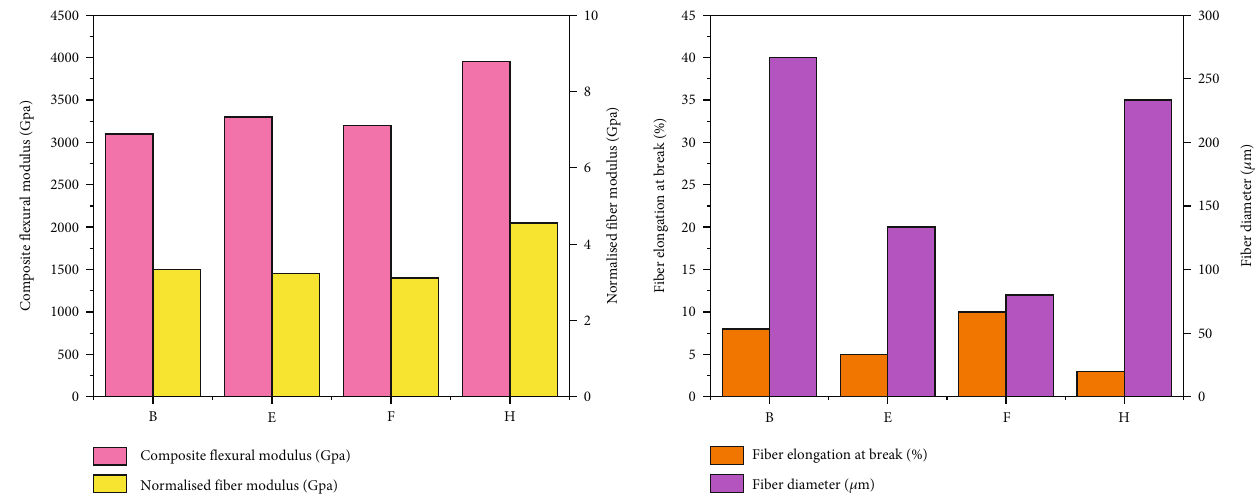
Figure 6: The impact on the composite fl exural modulus, normalised fi ber modulus, fi ber elongation at break, and fi ber